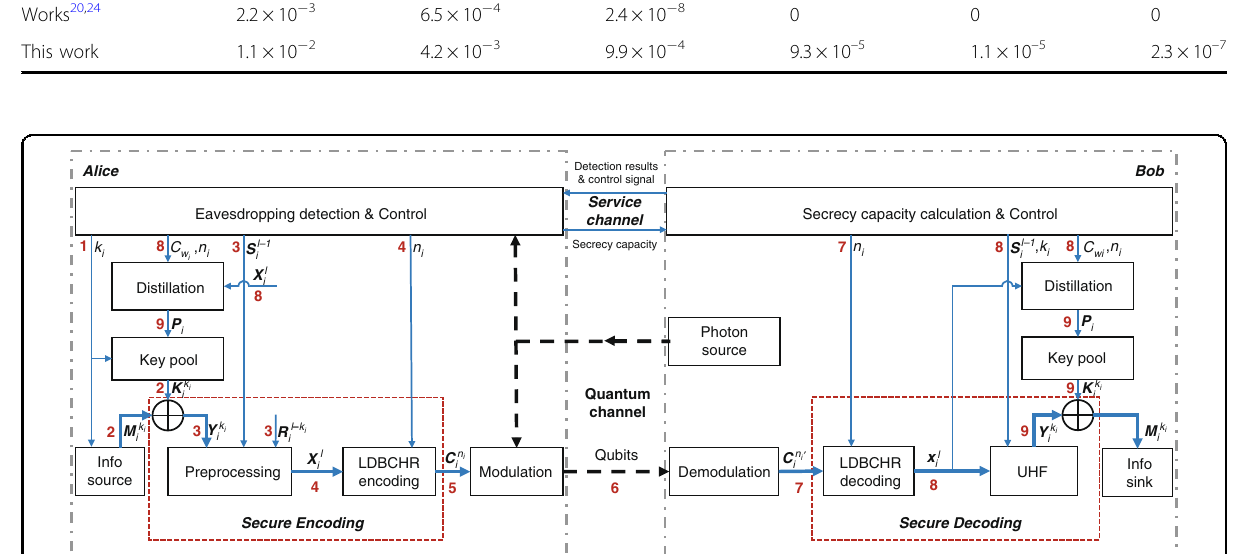
Fig. 4 Structure of our variant of QMF QSDC protocol and the data stream of the i -th frame. The black dotted lines carry qubits, and the blue lines carry classical bits. The rectangular boxes are the modules while the directed lines between them represent the data stream. Besides, the symbols near the lines are the data in the